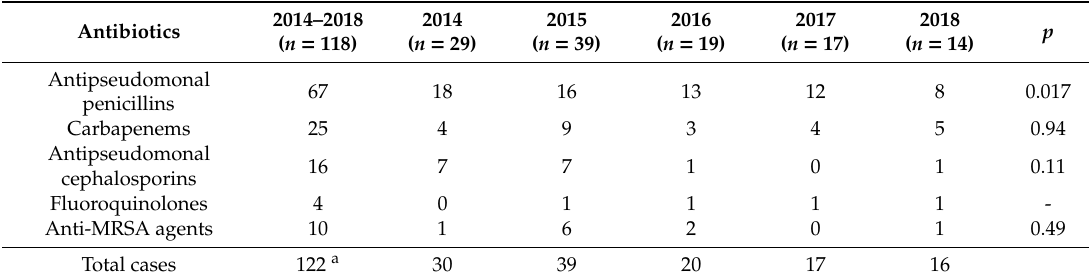
Table 2. Antibiotics prescribed for patients listed in Table